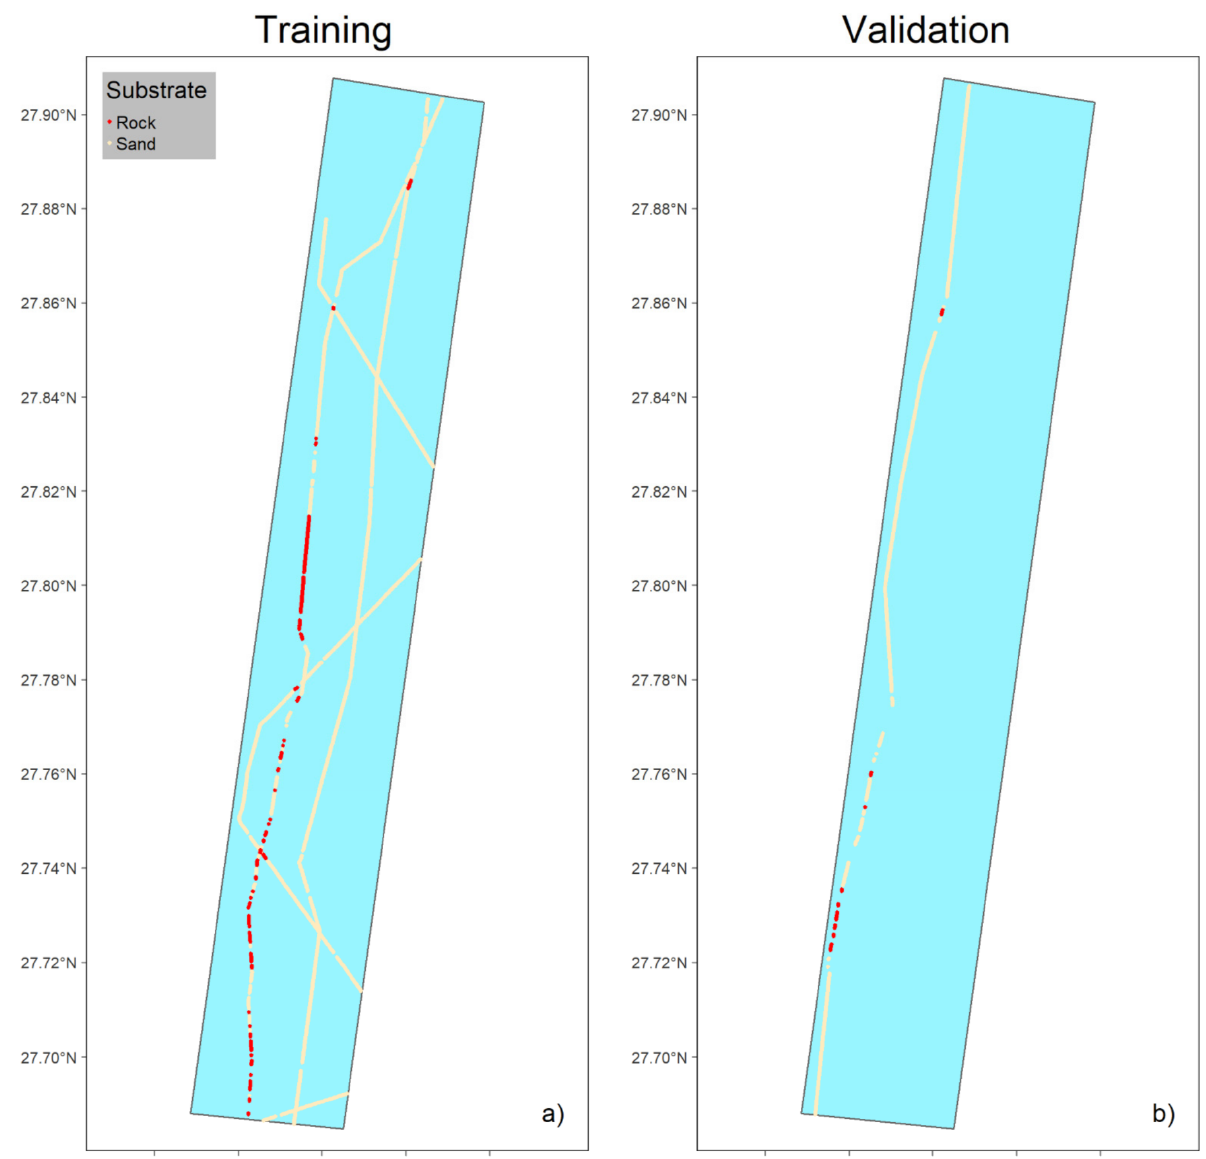
Figure 4. Ground-truth observations of substrate from the towed video system for training ( a ) and validation ( b ) of statistical substrate classification models. The blue area represents the multibeam echosounder (MBES) survey